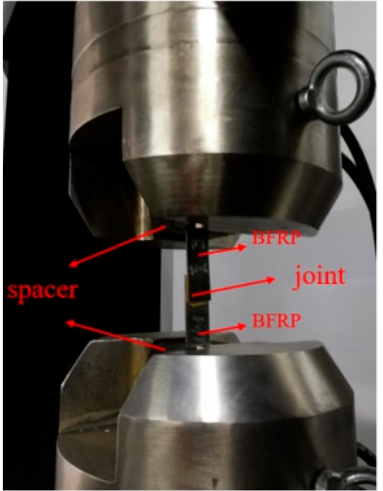
Figure 6. Schematic drawing of the stretching process.